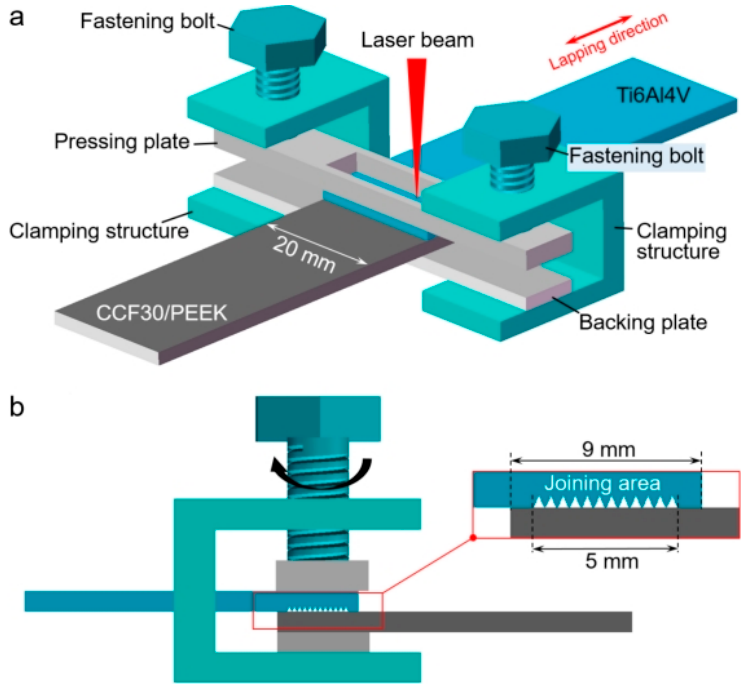
Figure 3. Schematics for laser joining of Ti6Al4V and CCF30/PEEK. ( a ) Diagram showing the laser joining process. ( b ) Diagram showing the lapping and joining area.